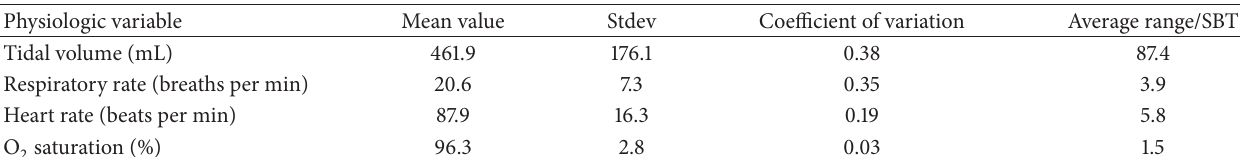
Table 4: Measures of variance for physiologic variables (tidal volume, respiratory rate, heart rate, and O 2 saturation). Expressed as mean, standard deviation, coefficient of variation, and average range per spontaneous breathing trial (SBT).